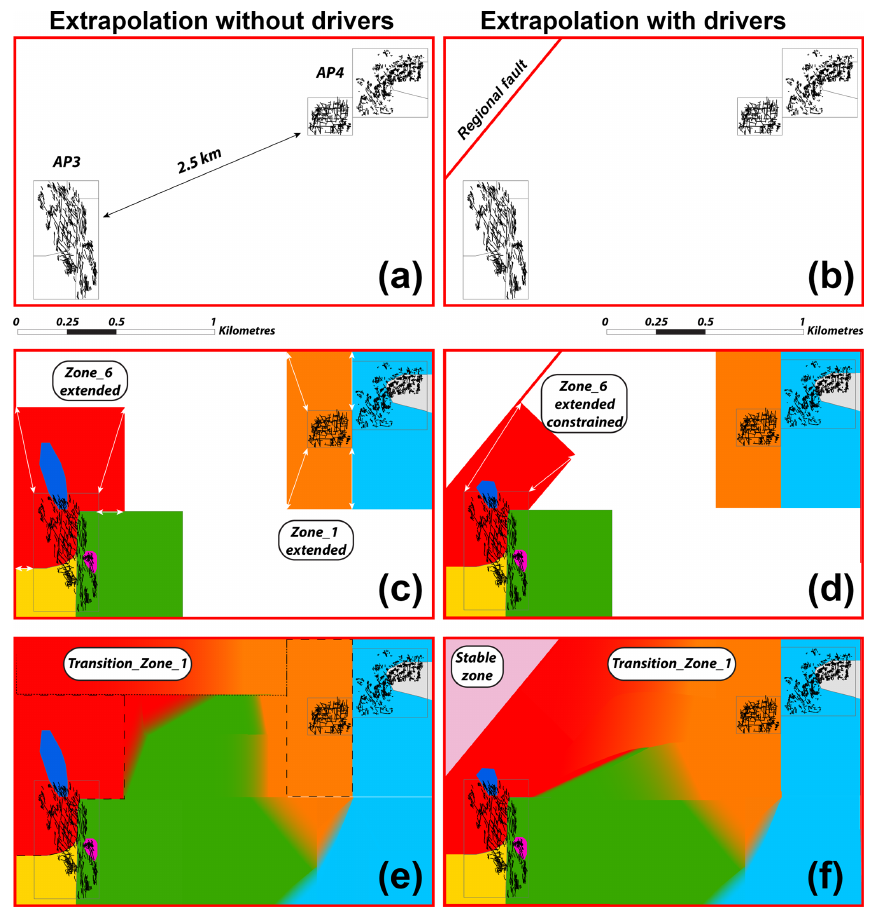
Figure 13. Smooth probability map at the reservoir scale (combination of AP3 and AP4). (a) Relative position of the AP3 and AP4 outcrops. (b) Apodi fault added into the area of interest. Extension of the probability map regions in AP3 and AP4 without geological drivers (c) and with the influence of the Apodi fault (d) . Probability maps with smooth transition zones without geological drivers (e) and with the influence of the Apodi fault (f)